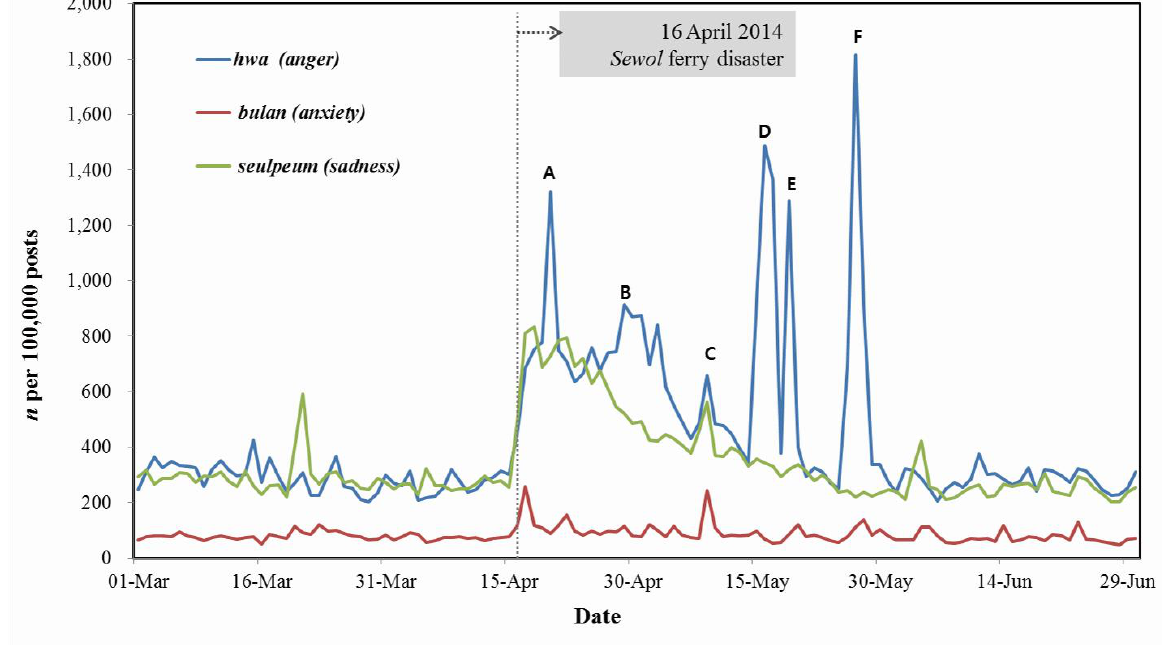
Figure 2. The Sewol ferry disaster and negative emotional reactions. ( A ) 20 April, the government declared the affected area a disaster zones. ( B ) 29 April, South Korean president Park Geun-hye visited the memorial alter for victims of the sunken Sewol ferry. The death toll surpassed 200 as the Sewol search intensified. ( C ) 09 May, There were reports that the sunken Sewol ferry was beginning to collapse. ( D ) 17 May, Nationwide rallies in Seoul held to protest government response to ferry sinking. ( E ) 19 May, President Park Geun-hye apologized for the sinking of the Sewol during an address to the nation. ( F ) 26, 27 May, Critical rumors about the government response to Sewol disaster was rapidly spread abroad on SNS and other media. These were the most widely re-tweeted on